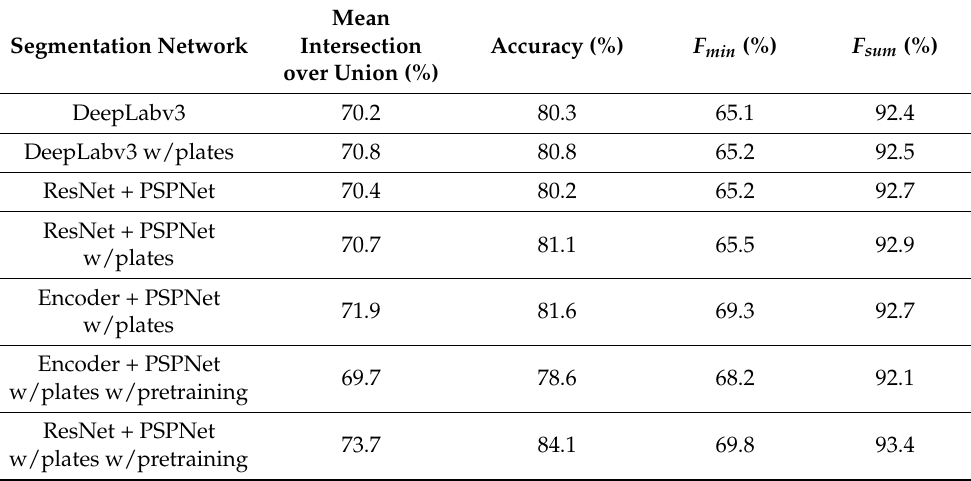
Table 2. The segmentation results for the different network